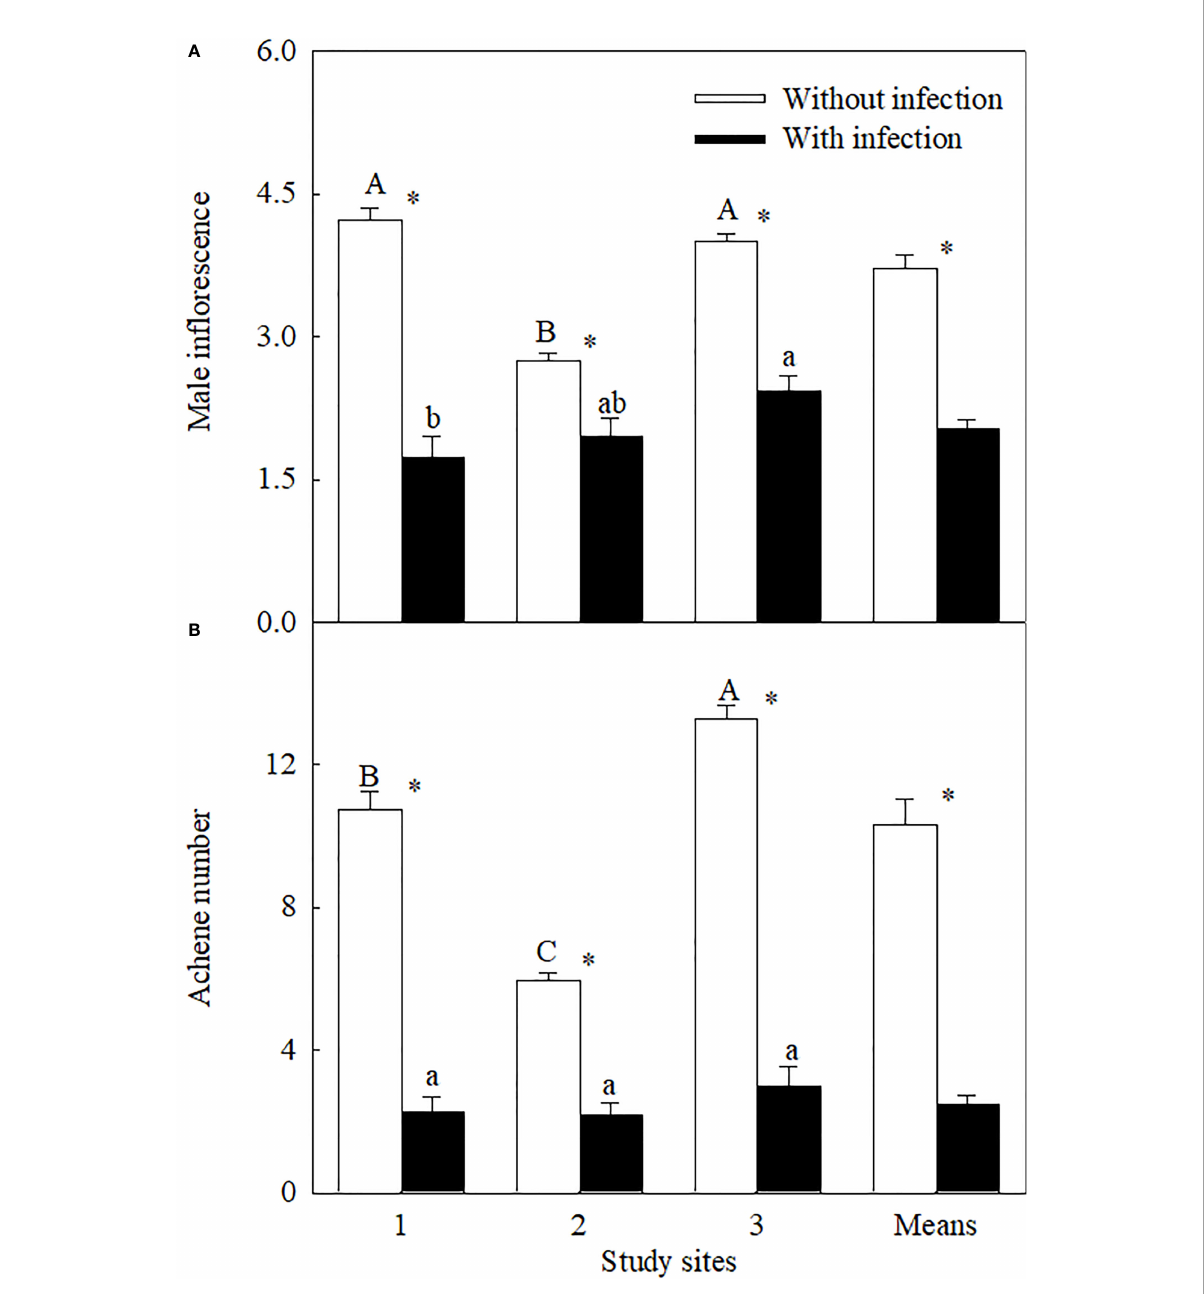
FIGURE 2 The number of male super-in fl orescence (log 3 -transformed;) (A) and achene (square-root-transformed; ( B ) of Ambrosia tri fi da uninfected (open bars) and infected (closed bars) by Cuscuta japonica at different sites. Means + 1 SE ( n = 6). Different upper- and lowercase letters indicate signi fi cant differences among sites for uninfected and infected plants, respectively ( P < 0.05; one-way ANOVA); * indicates signi fi cant difference between uninfected and infected plants at the same site ( P < 0.05; independent sample t